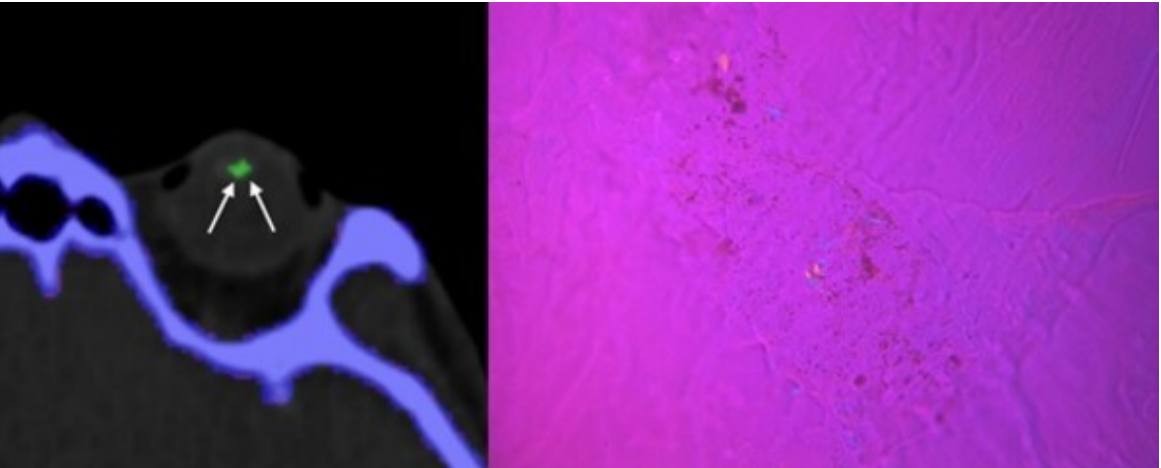
Figure 1. 80-year-old male cadaver. Axial DECT image showing Score 1 MSU deposit in the left lens (white arrows). Corresponding microscopic image taken from the lens, showing diffuse packed and patchy MSU deposits with strong negative birefringence (bluish structures).